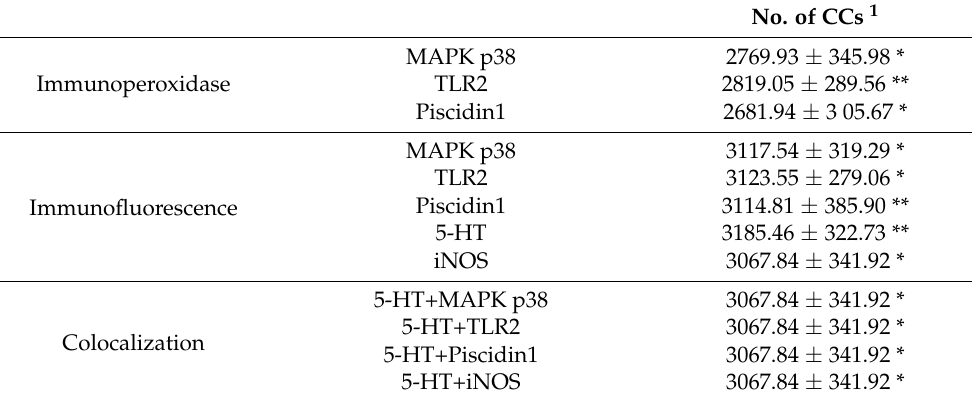
Table 2. Quantitative analysis results (mean values ± standard deviations; n =